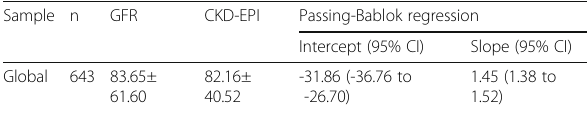
Table 1 (abstract 000595). See text for description Sample